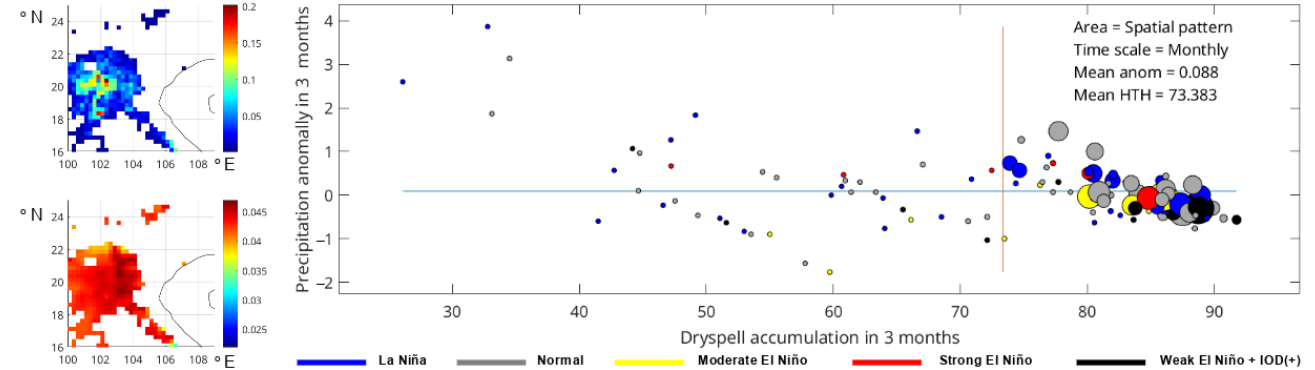
Figure 4. Thailand—spatial graph of hotspots ( top ) and dry spells ( bottom ) as well as bubble plot of the monthly fire events for all categories. Blue and orange lines represent average value of respective variables. Size of the bubble represents the number of hotspots for each particular month. Extracted from first mode of SVD with 98% of SCF value.